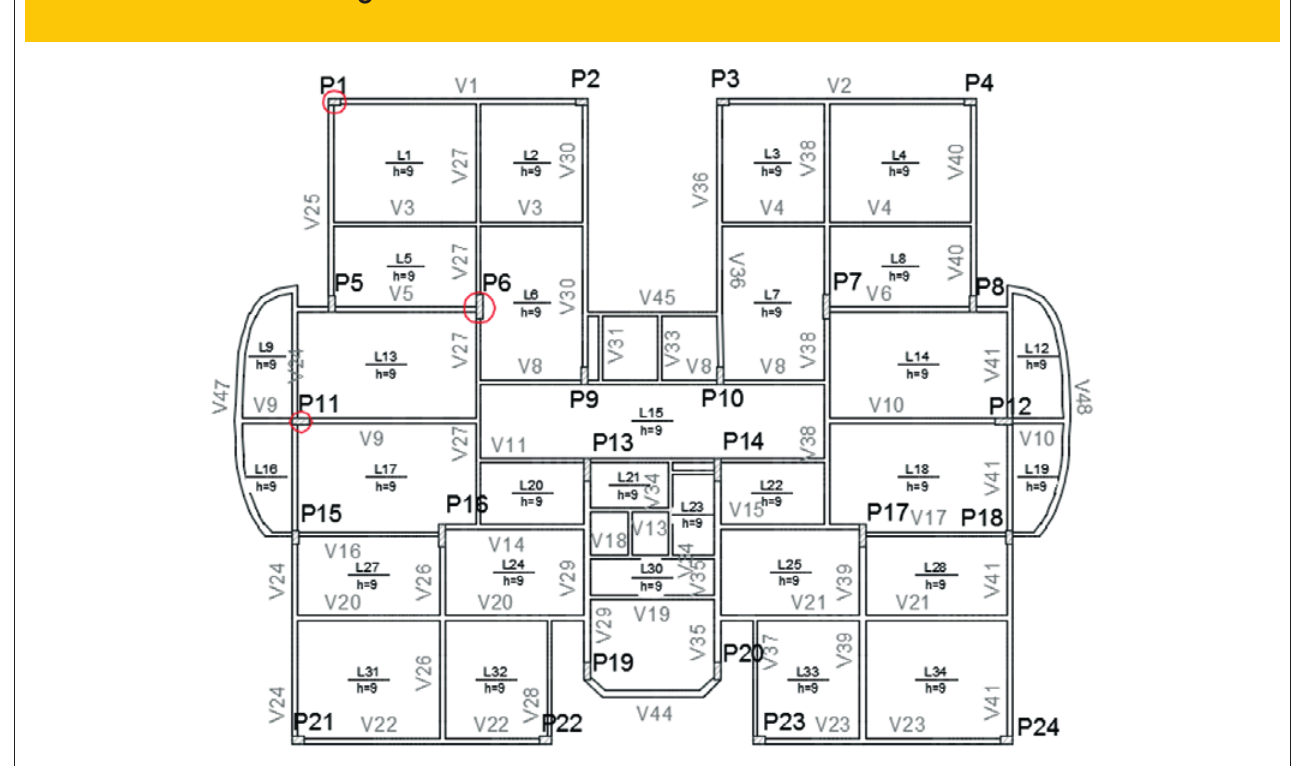
Figure 4 – Plan of the structure for the 10-floor